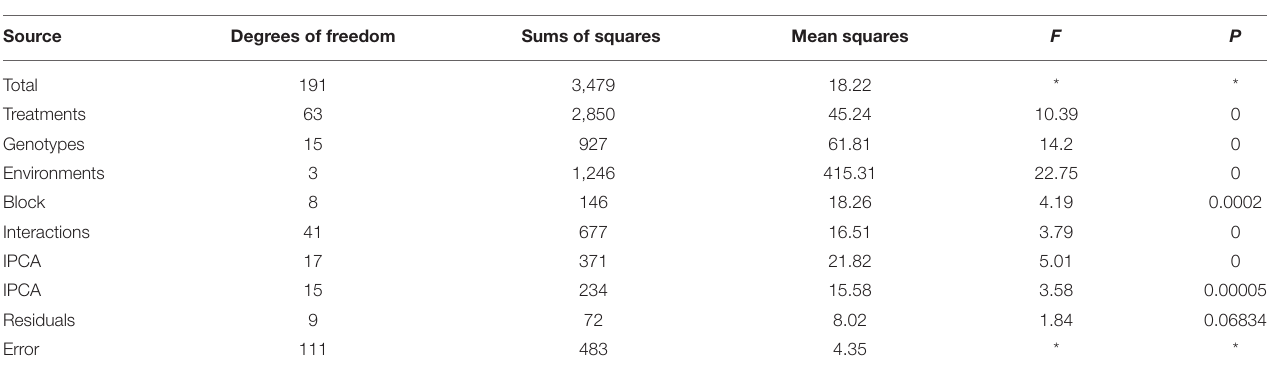
TABLE 2 | AMMI analysis of variance.